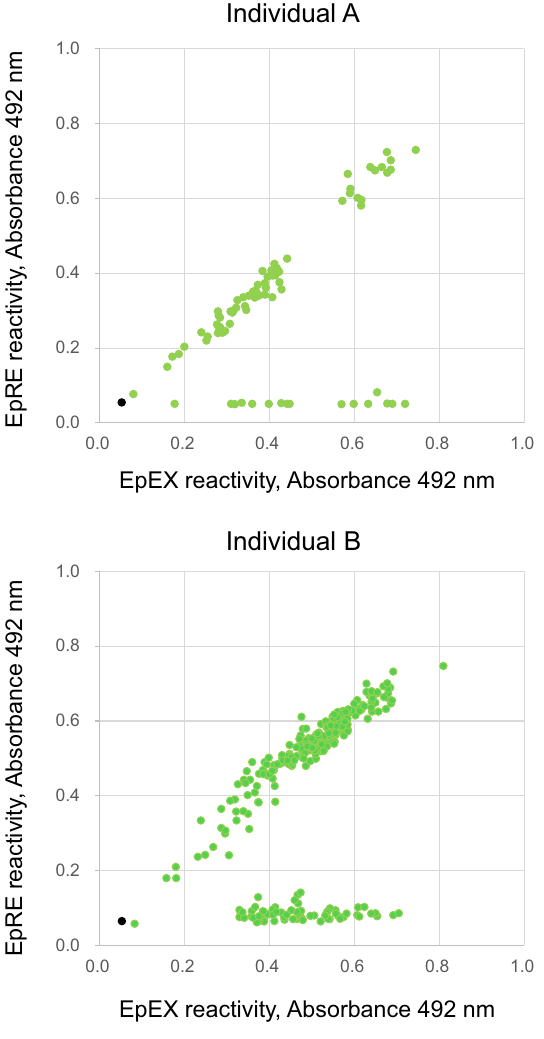
Figure 2. ELISA of monoclonal antibodies. Overall, 80 and 297 mAbs obtained from individuals A (upper) and B (lower) were analyzed by ELISA. The signals of EpEX and EpRE are plotted, showing two groups. The first group that reacts proportionally with the EpEX and the EpRE contains mAbs that react with the EpRE domain of EpCAM. Meanwhile, the other group that reacts with the EpEX but not the EpRE contains mAbs that react with the EpCL domain. Therefore, the first group can be defined as the EpRE-reactive mAbs and the second group as the EpCL-reactive mAbs. Black dot in each graph indicates the value for the negative control value obtained using the medium without